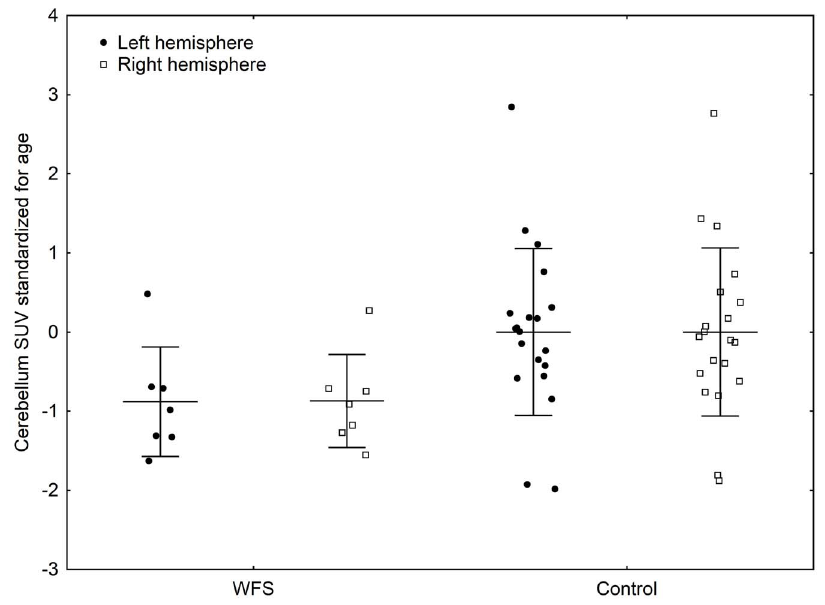
Fig. 3. Mean SUVand SD values (standardized for age) for the right and left cerebellum hemispheres in WFS and control groups.